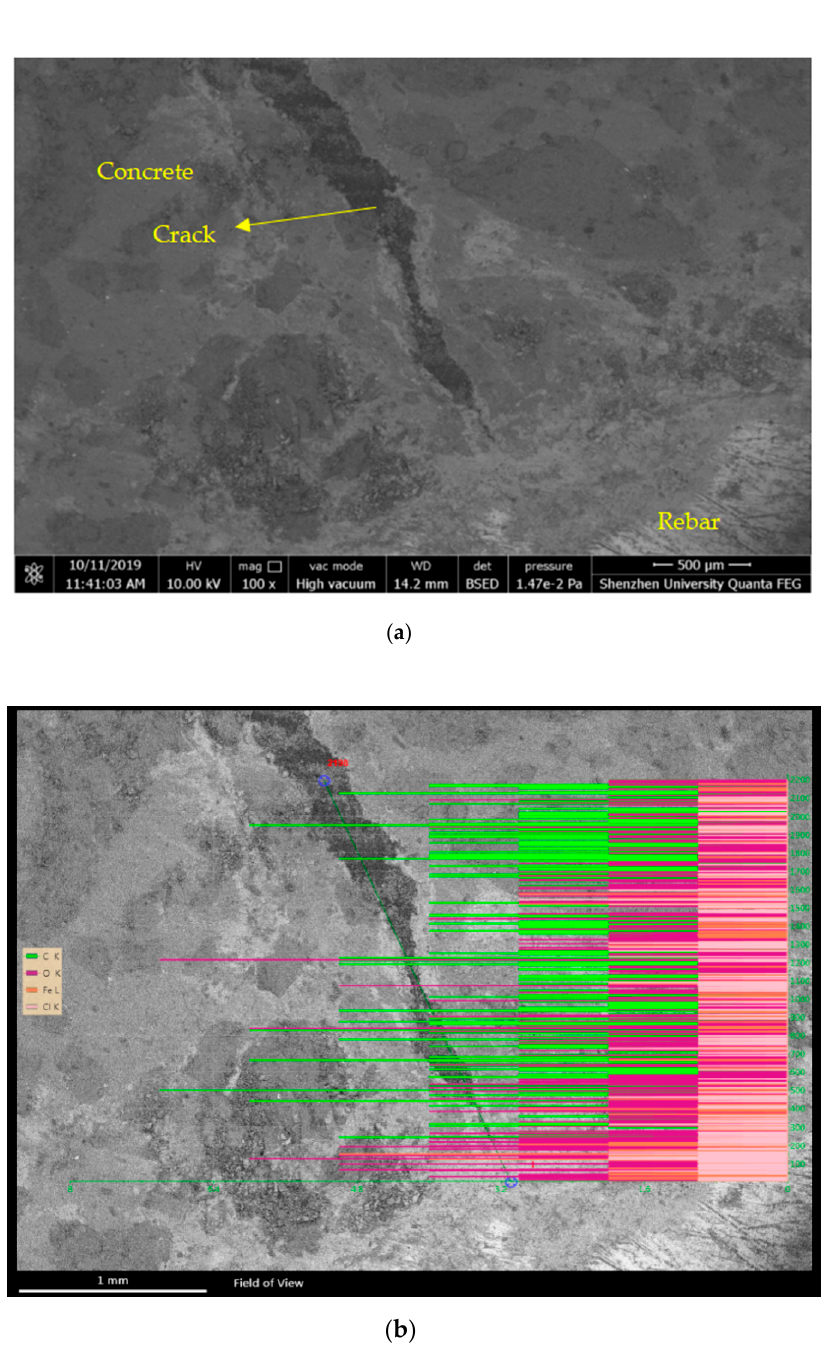
Figure 13. Distribution of corrosion products in a concrete crack. ( a ) SEM image of a concrete crack; ( b ) energy spectrum analysis line and strength distribution of each element in the concrete crack.